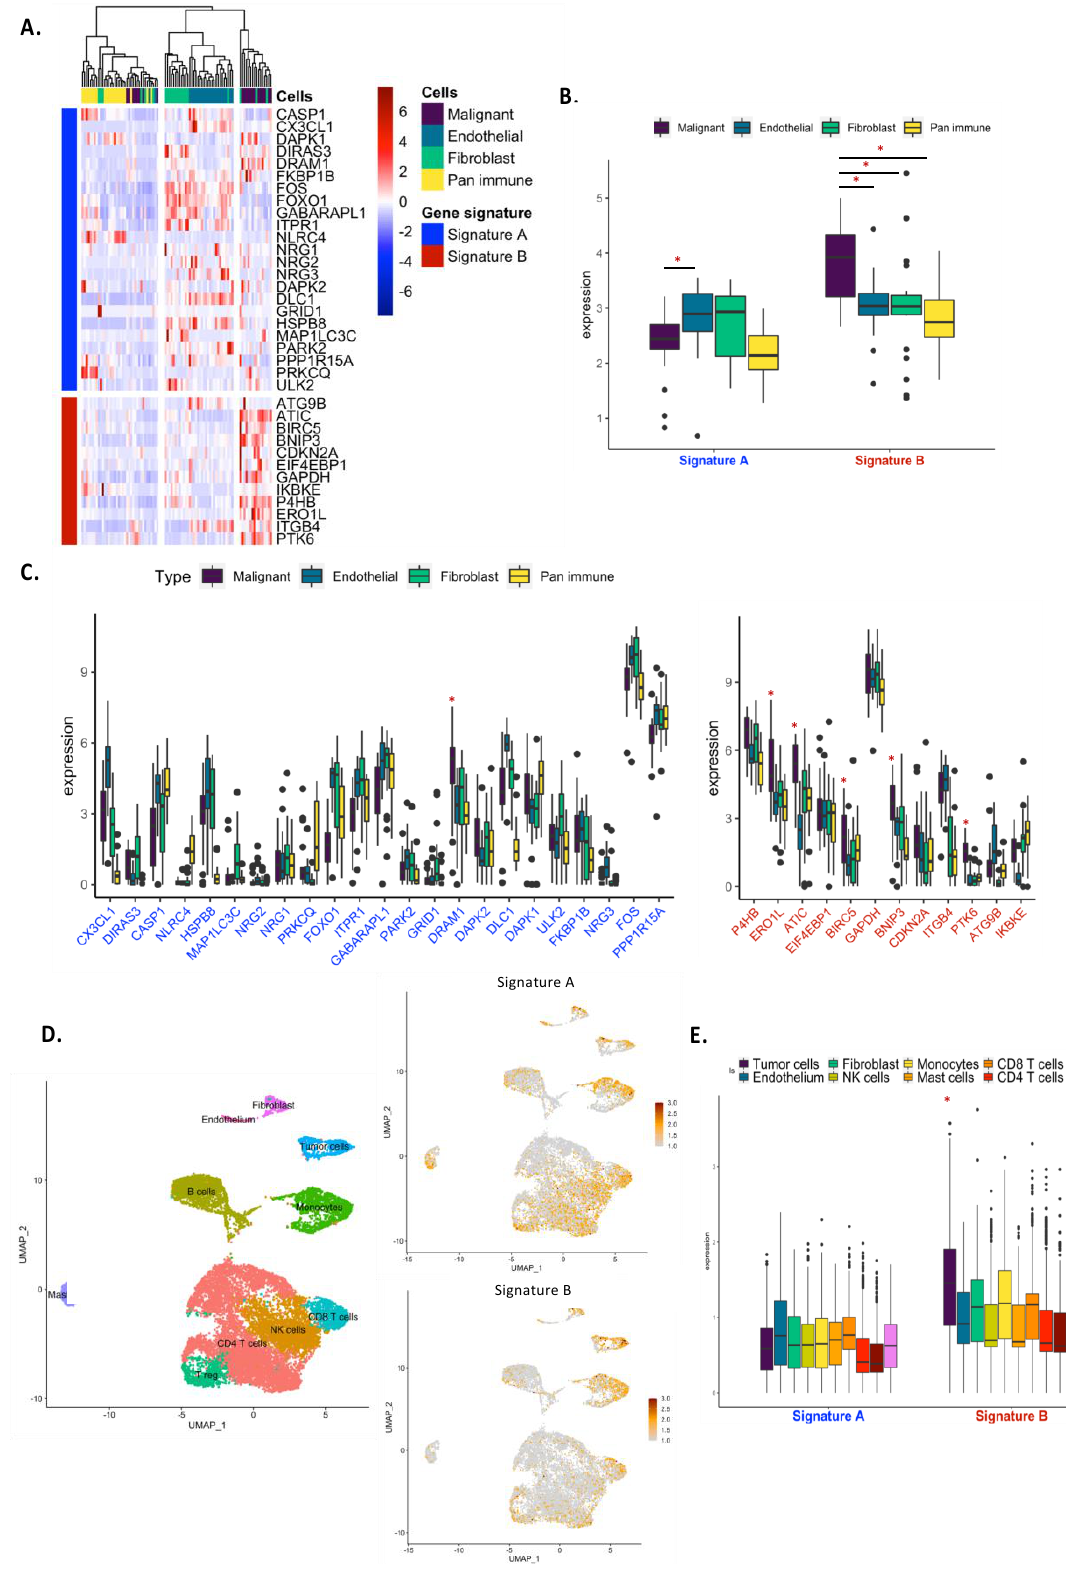
Figure 5. Expression of autophagy-related signatures in different subtypes of TME. ( A ) Unsupervised clustering of cell types using autophagy gene signatures in the GSE111907 datasets. ( B , C ) Expression of autophagy gene signatures according to cell types in the GSE111907 datasets. ( D , E ) Single-cell analysis of autophagy gene signature expression in the GSE123904 datasets. *, p -value <